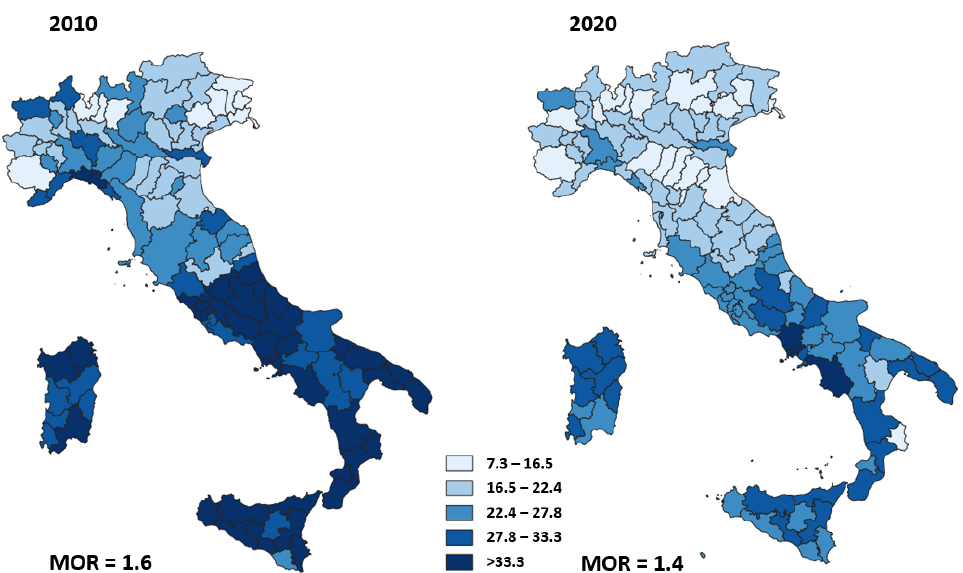
Figure 7. Proportion of primary caesarean deliveries. Italy, 2010–2020.